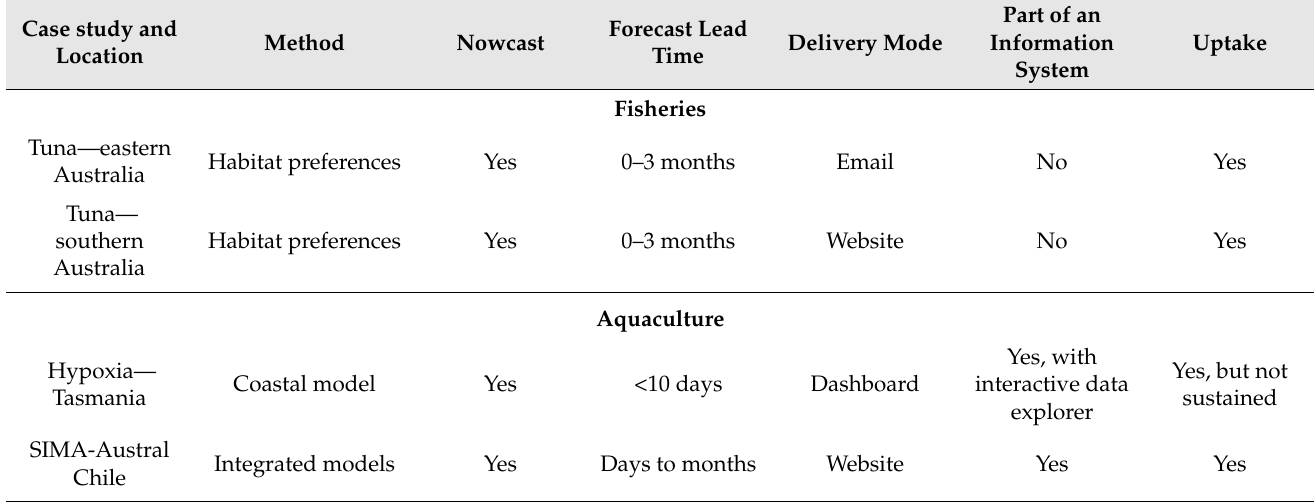
Table 1. Case study summary showing the model method, delivery of a nowcast, forecast lead time, use of an information system, and uptake by end